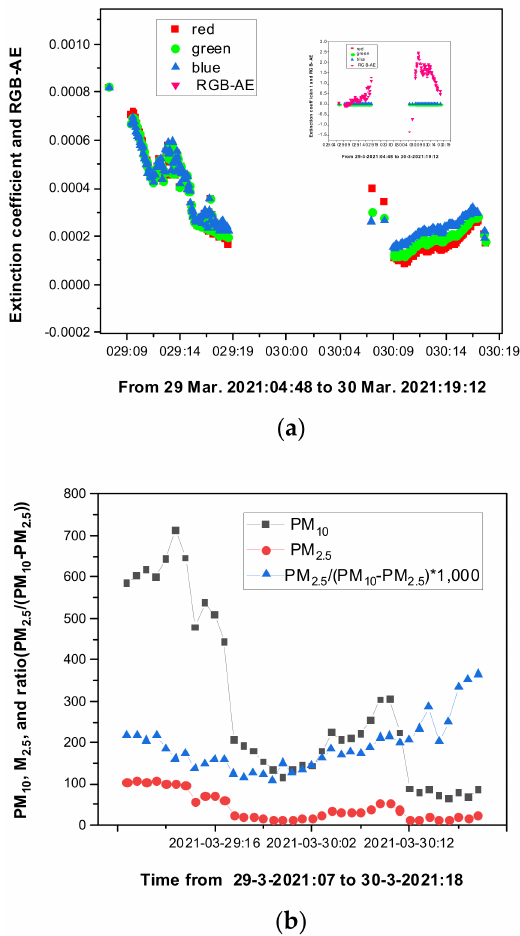
Figure 12. RGB-AE values and extinction coefficients obtained from camera images and PM obtained via the Ministry of Environment Observation network. ( a ) RGB-AE values and extinction coefficients. ( b ) PM 10 , PM 2.5 , and their